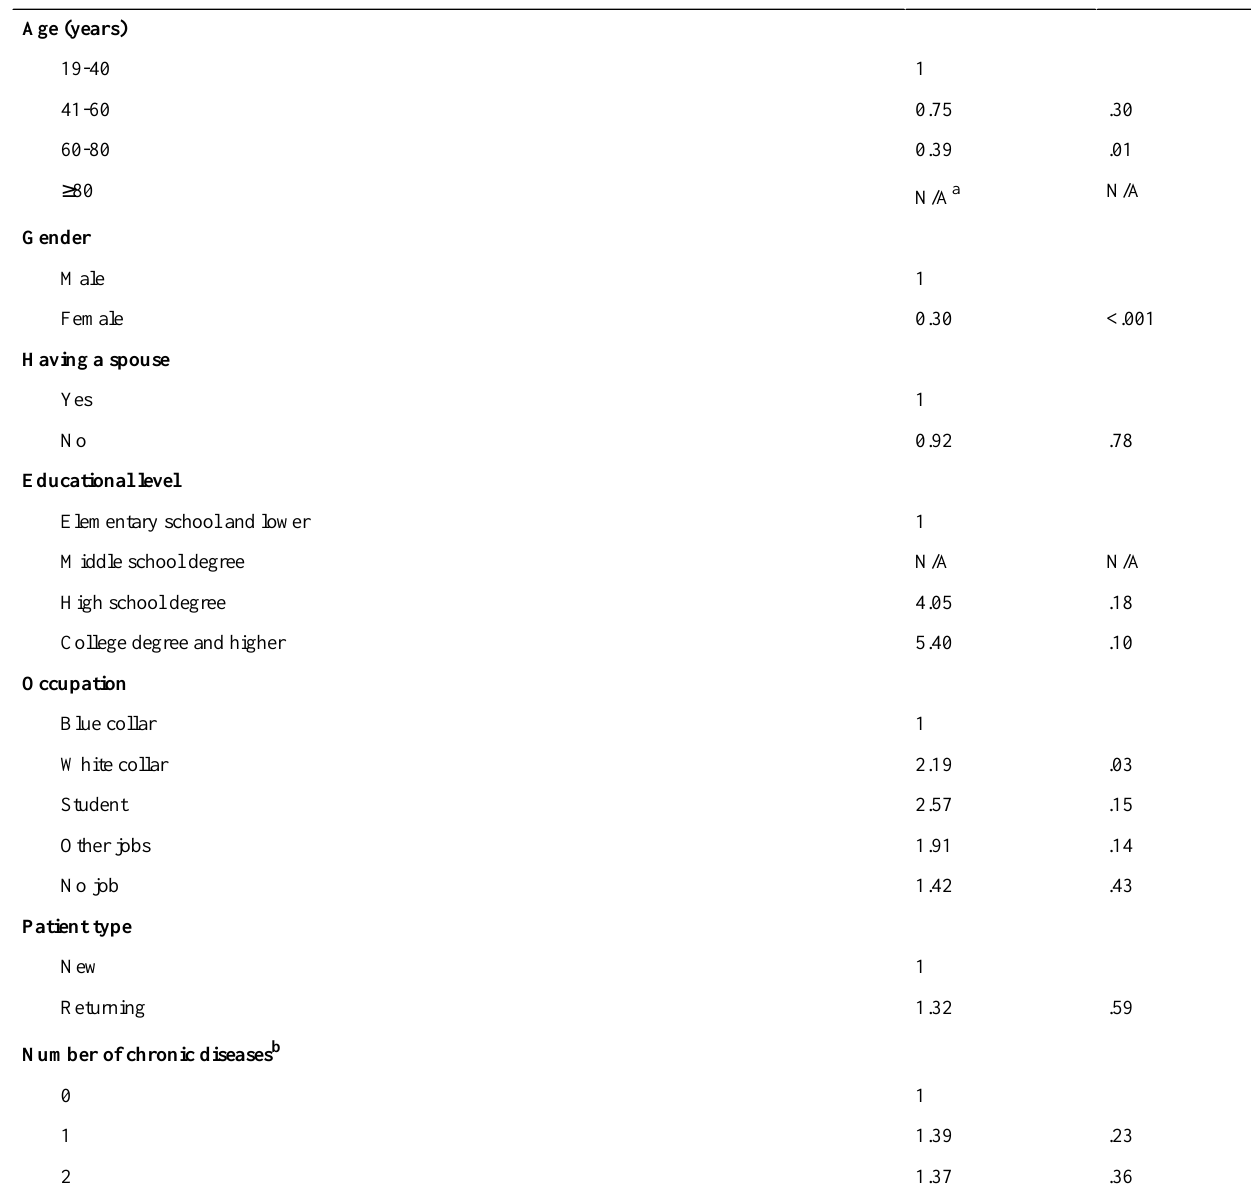
P valueAdjusted odds